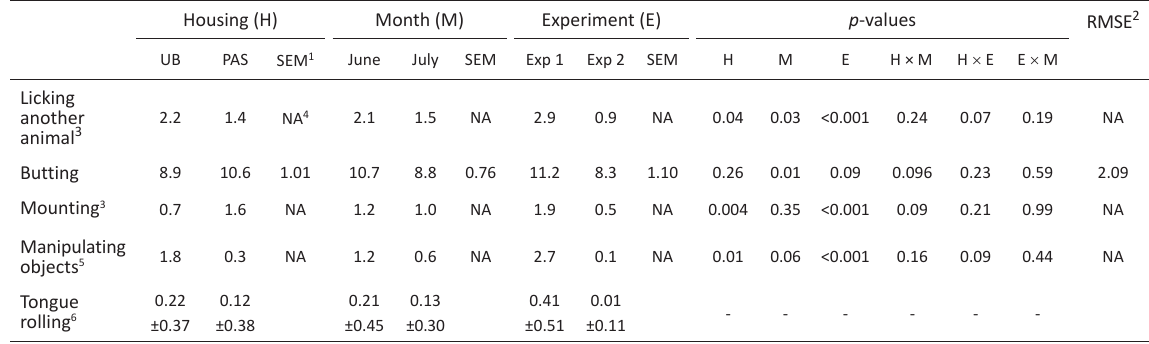
Table 4. Occurrence of different behavioural patterns as a percentage of all sample intervals during one-zero sampling in June and July between 0000–2400 h of bulls housed in an uninsulated barn (UB) or at pasture (PAS) in two experiments Housing